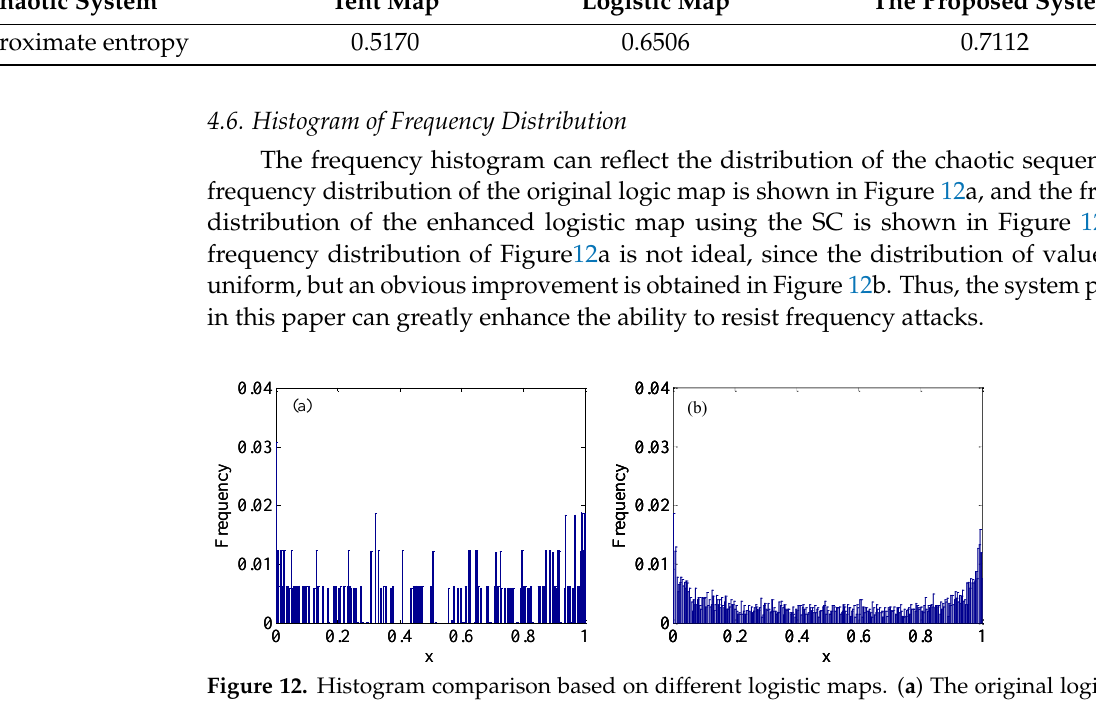
Table 1. Approximate entropy comparison based on three chaotic maps. Chaotic System Tent Map